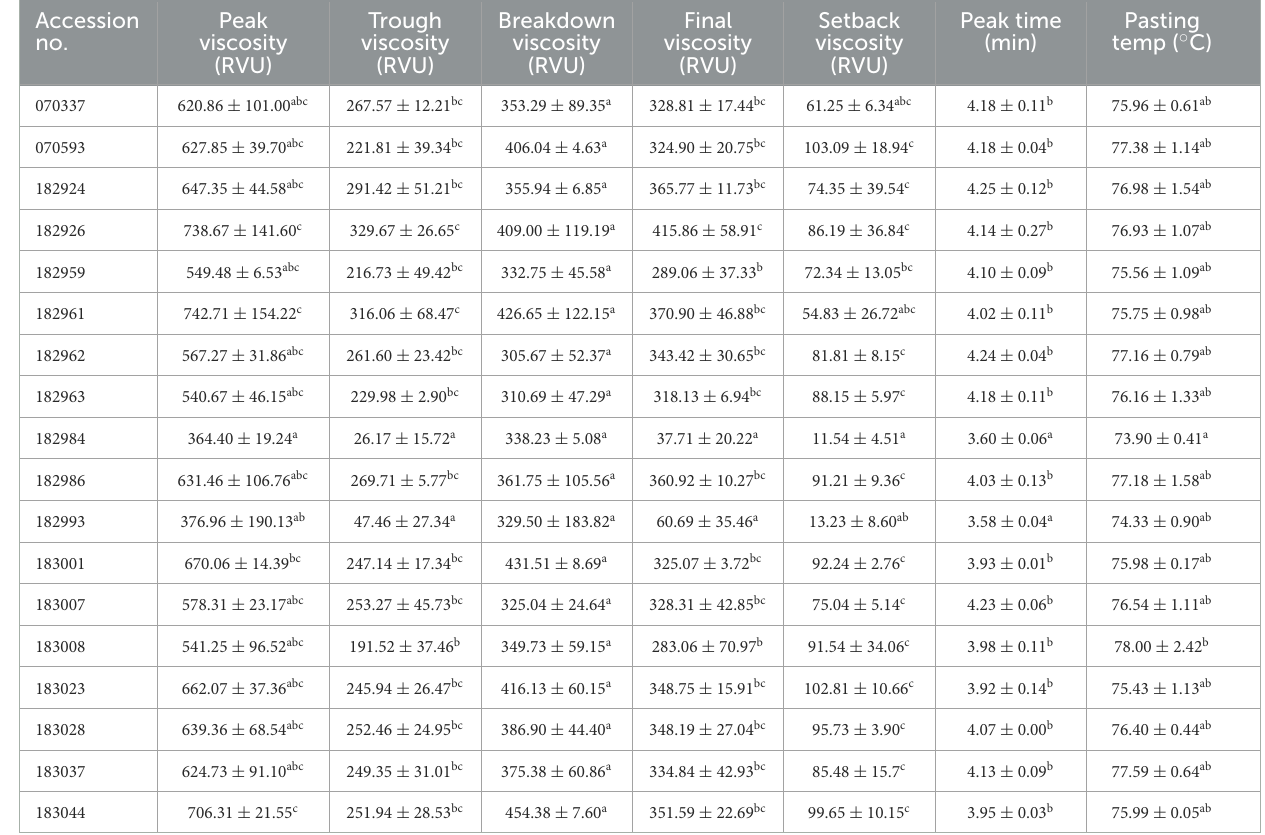
TABLE 5 Pasting properties of flours of 18 elite yellow-fleshed cassava genotypes. Accession